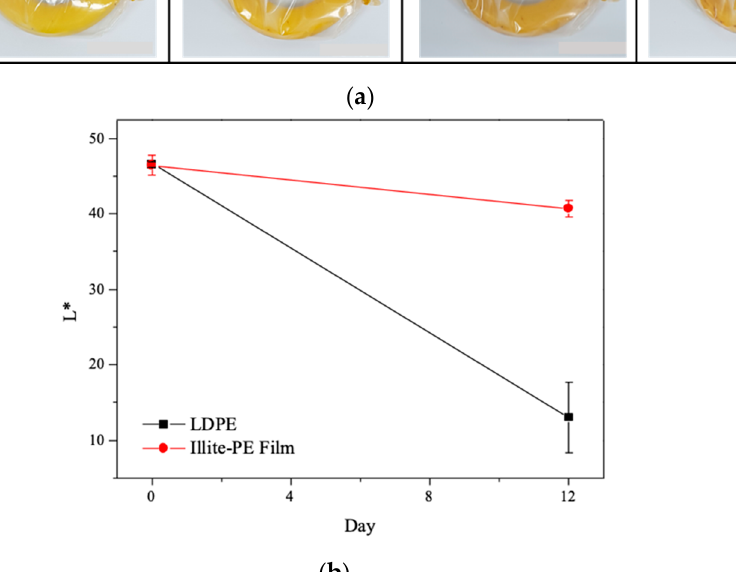
Figure 6. Comparison of ( a ) freshness-maintenance property and ( b ) chromaticity changes of illite–PE film and control LDPE for 12 days.